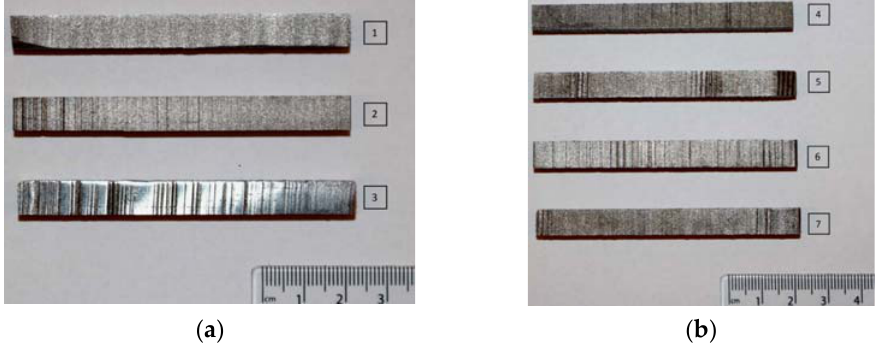
Figure 2. The 3D printed metallic bars: ( a ) sample No. 1–3 were printed horizontally and ( b ) sample No. 4–7 were printed vertically. Table 1. Primary dimensions and magnetic properties of the samples.